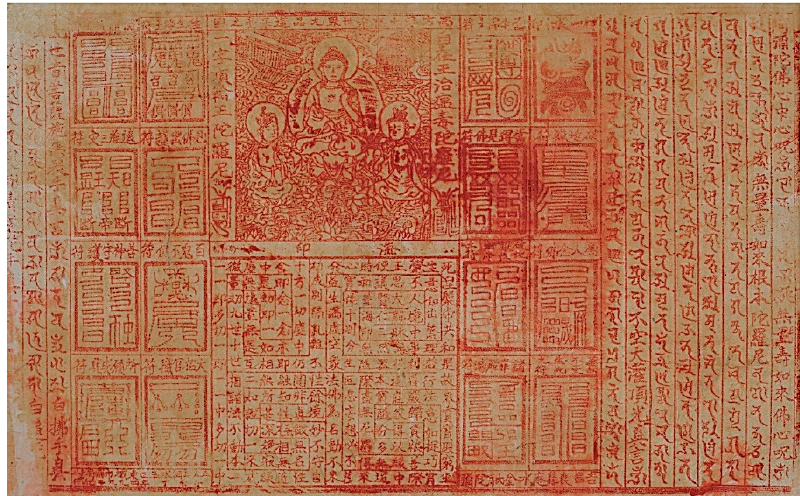
Figure 4. Casket Seal Dharani (K. Bohyeopin darani ), Goryeo (1007), 32.3 × 45 cm, Enshrined in the statue Wooden Seated Avalokitesvara of Bogwangsa Temple. Source: (Central Buddhist Museum 2014, p. 99).